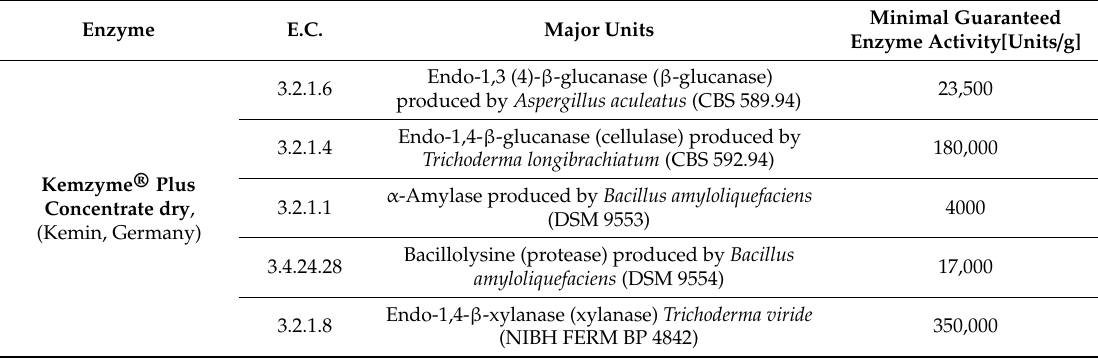
Table 4. Preferential enzymes and major active unit of enzyme formulation